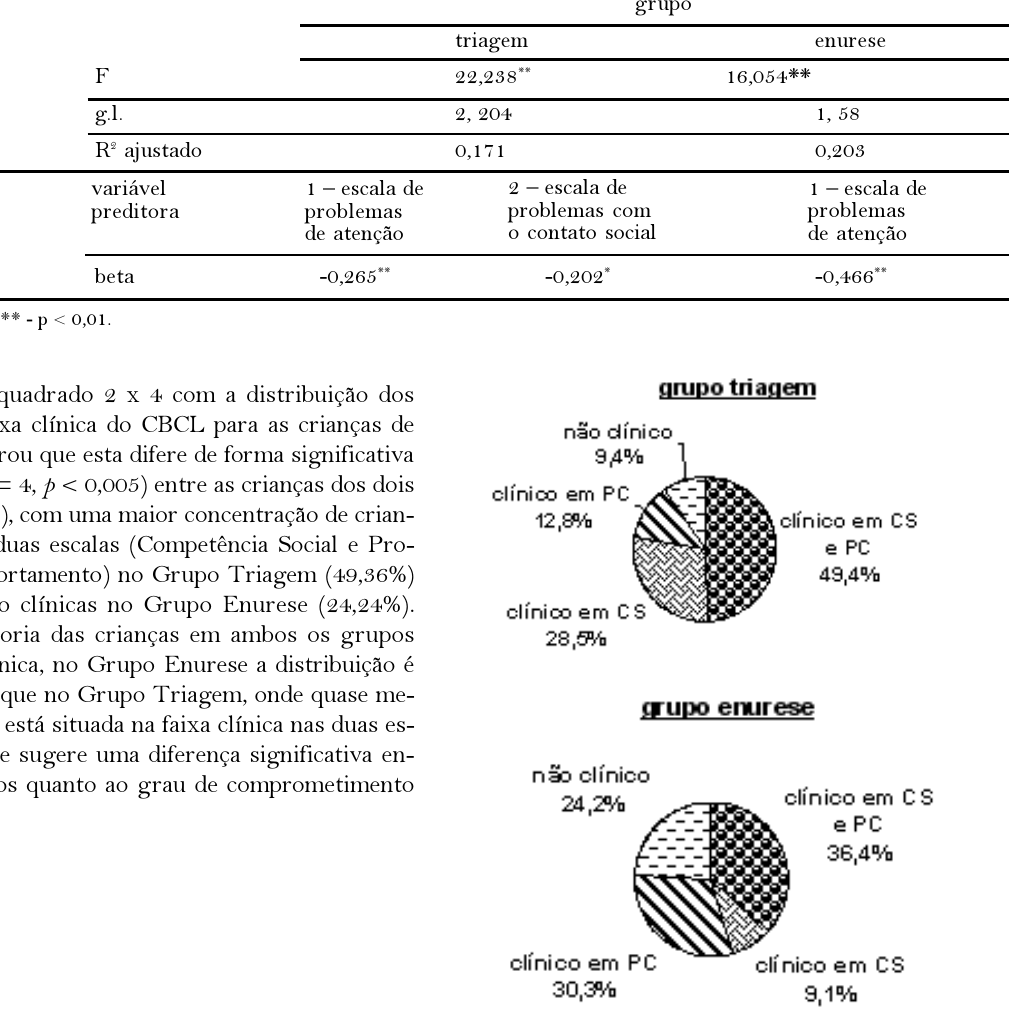
Figura 2 . Distribuição dos resultados do CBCL dos grupos triagem (n = 235) e enurese (n =